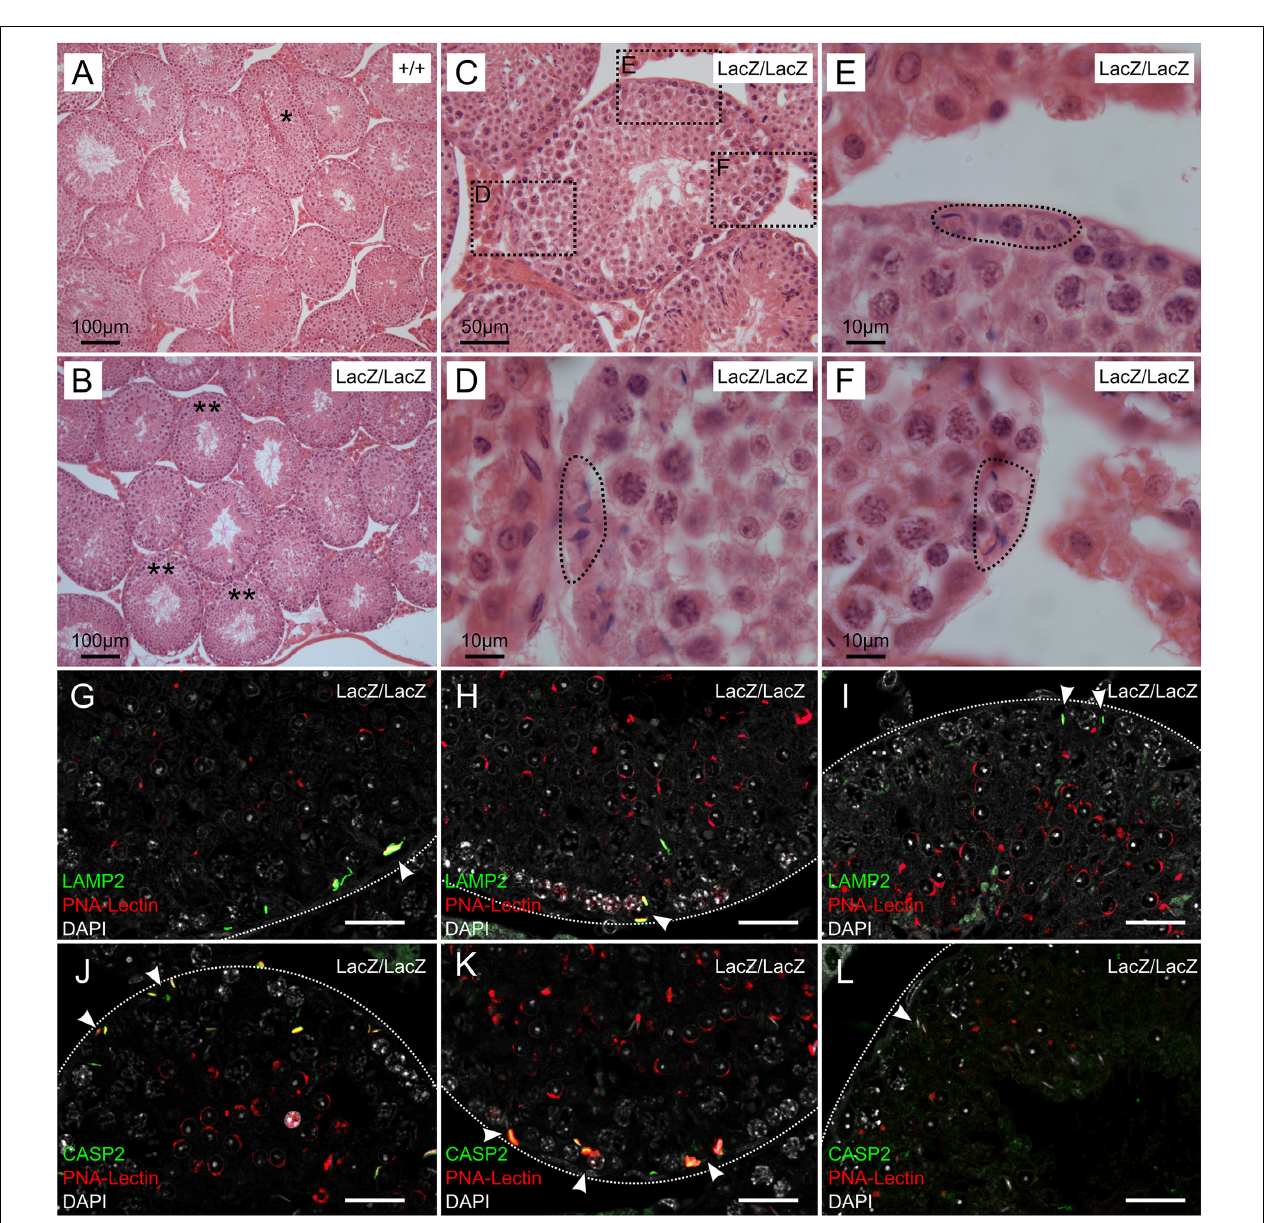
FIGURE 2 | Immunochemical staining of caspase 2 and LAMP2 in Fbxo7LacZ/LacZ testis sections. (A–B) Low magnification view of H&E sections from wild type (A) and Fbxo7LacZ/LacZ testes (B) . ∗ In panel (A) indicates a tubule at stage VII-VIII with sperm heads lined up at the lumen awaiting release. These were never observed in Fbxo7LacZ/LacZ testes. ∗∗ In panel (B) indicates tubules with a layer of round spermatids but which lack elongating spermatids. (C) High magnification view of a Fbxo7LacZ/LacZ tubule lacking elongating spermatids: (D–F) Close up zoom from panel C at the indicated locations. The dotted outlines indicate “graveyards” containing multiple phagocytosed spermatid heads. (G–I) Immunofluorescent stains in Fbxo7LacZ/LacZ tubules for LAMP2 (green) with PNA-lectin (red) to stage the tubules and DAPI counterstain (gray). Phagocytosed cells marked by LAMP2 were visible at tubule stage VI as indicated by the extent of the lectin-stained acrosomal cap. (J–L) Immunofluorescent stains in Fbxo7LacZ/LacZ tubules for CASP2 (green) with PNA-lectin (red) to stage the tubules and DAPI counterstain (gray). Apoptotic cells marked by CASP2 were visible at tubule stage VI as indicated by the extent of the lectin-stained acrosomal cap. At tubule